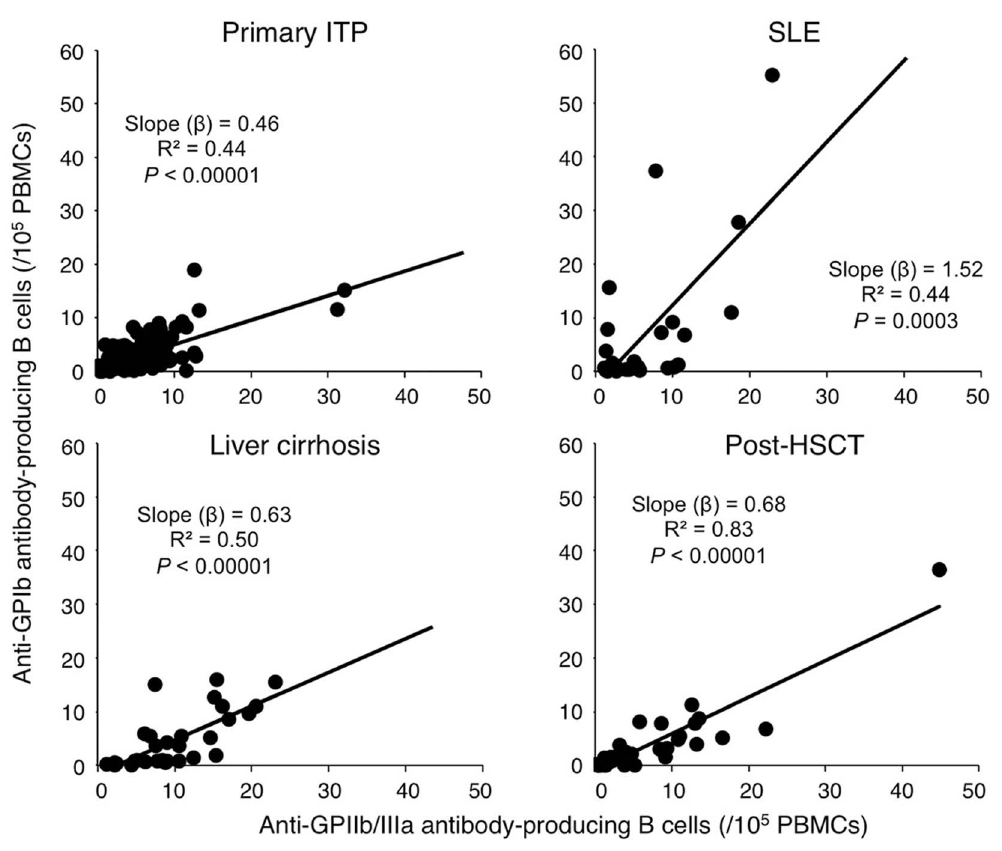
Figure 2. Correlations between circulating anti-GPIb and anti-GPIIb/IIIa antibody-producing B cells in patients with primary ITP, SLE, liver cirrhosis, and post-HSCT.